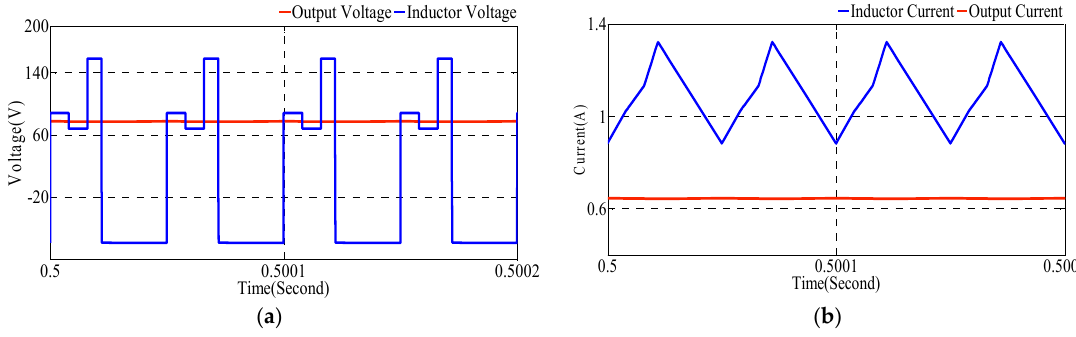
Figure 9. Simulation waveforms for buck-boost operation of the MBDC converter when the duty ratio